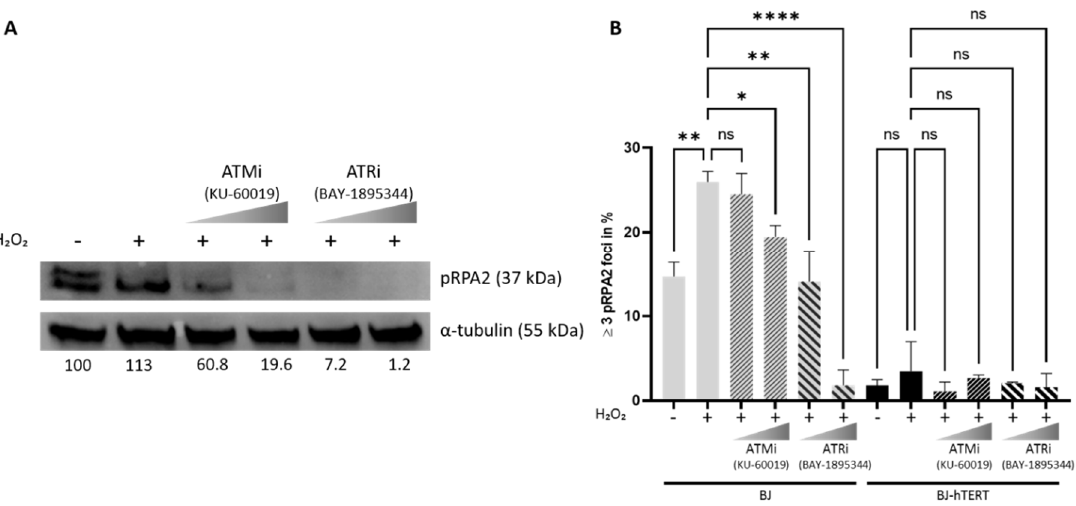
Figure 10. Inhibition of ATM or ATR impairs ROS-induced replication stress in BJ cells. BJ and BJ-hTERT cells were subjected to the inhibitors KU-60019, an ATM kinase inhibitor (1–3 µM), and BAY-1895344, an ATR inhibitor (5–25 nM) for 1 h, before the addition of 400µM H 2 O 2 for another hour. ( A ) A representative Western Blot showing the decrease of pRPA2 levels upon treatment with ATM and ATR inhibitors in BJ cells. As a loading control, α -tubulin is shown. Intensity ratios of the pRPA2 lower band normalized to α -tubulin, and relative to BJ cells without treatment, are indicated below the blot (in %). ( B ) The bar plot evaluates the impact of H 2 O 2 on pRPA2 foci formation after ATM and ATR inhibition in BJ and BJ-hTERT cells. One-way ANOVA test was applied, followed by a Fisher’s LSD post hoc test, with a confidence interval of 95%. A total of 310 cells were counted from n = 2 independent experiments. ns ( p > 0.05), * ( p ≤ 0.05), ** ( p ≤ 0.01), **** ( p ≤ 0.0001).